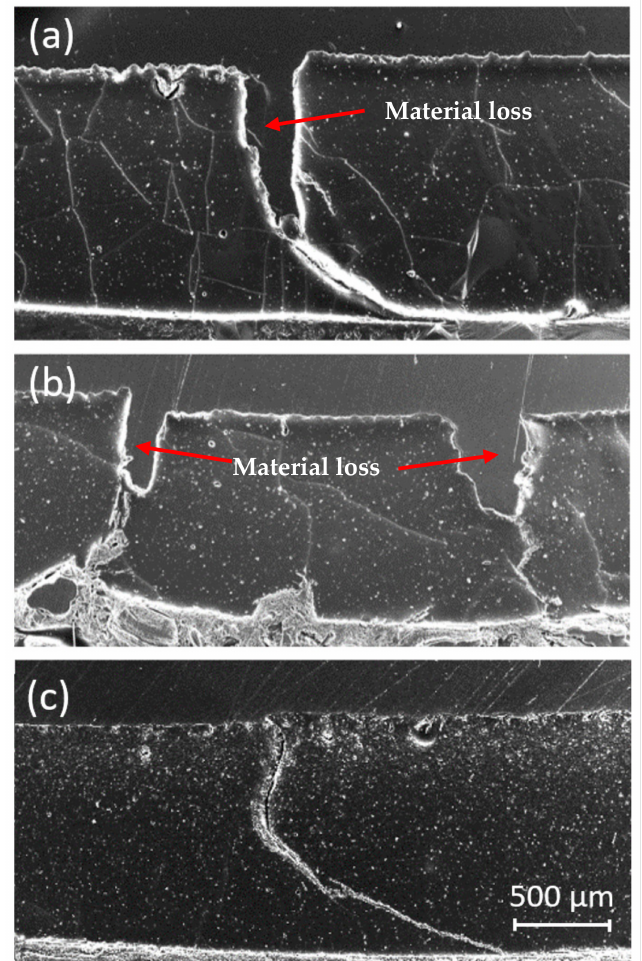
Figure 12. SEM micrographs of ( a ) PU, ( b ) PU + GNP, and ( c ) PU + GNP +